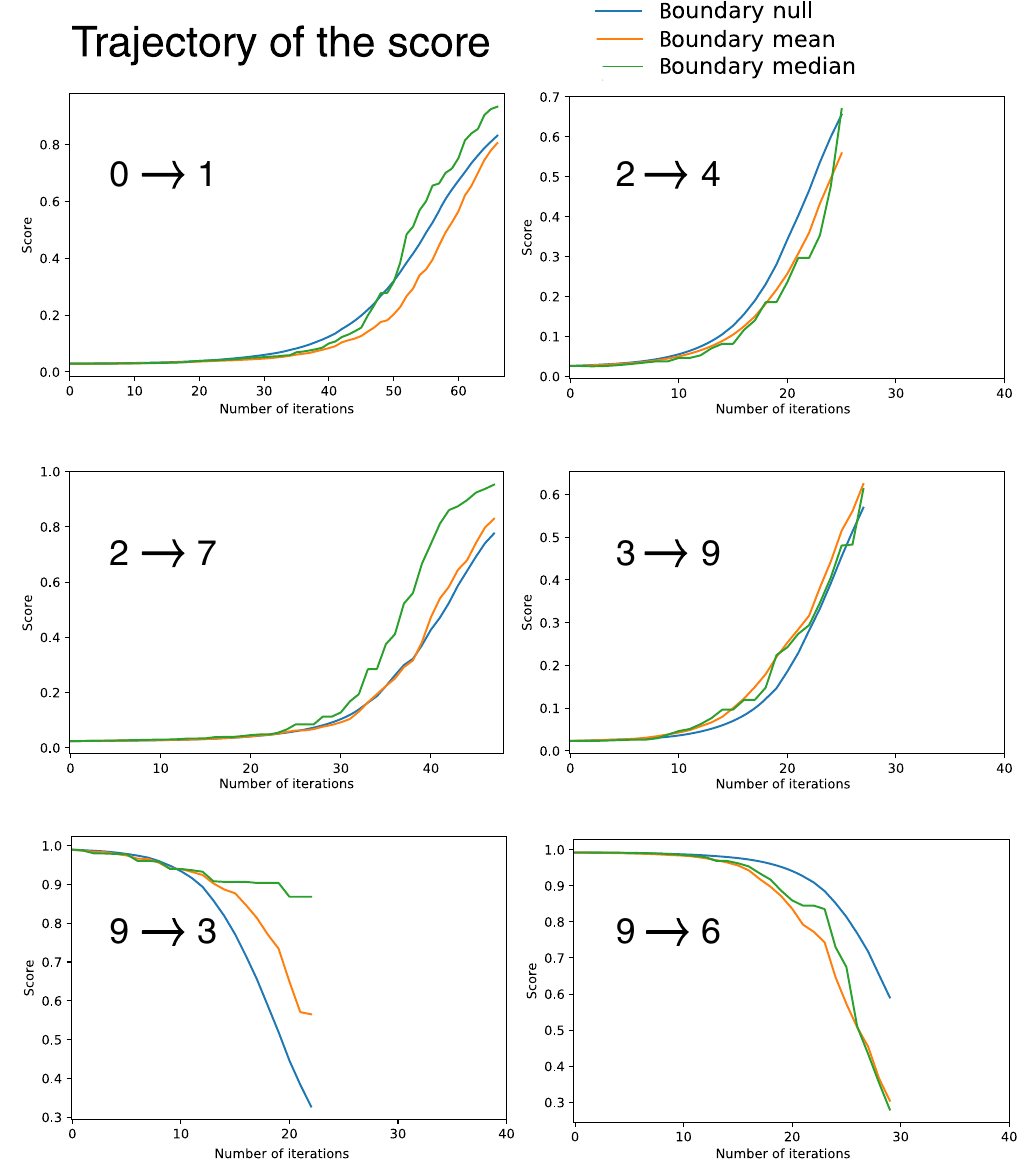
FIG. 8. Trajectory of the scoring functions of the attacks in Fig. 7. The blue, orange, and green lines correspond to various digits (actual digit, mean-filtered digit, median-filtered digit) for which we check the score and terminate when reaching the boundary. The trajectory of the score for the null digit and the mean-filtered digit is generally the same. Moreover, the behavior of the score looks similar to the behavior of T N;m upon addition of maximally antagonizing ligands to a mixture of only agonist ligands in Fig. 3(d) in the main